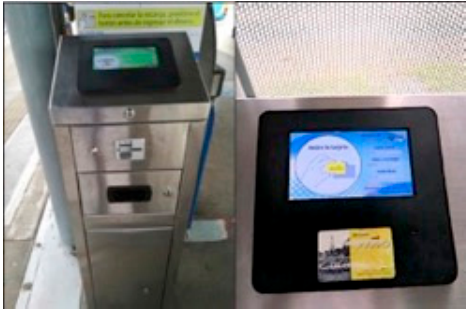
Figure 11. General overview and detailed closeup of Mío top-up terminal for public transport in Cali.